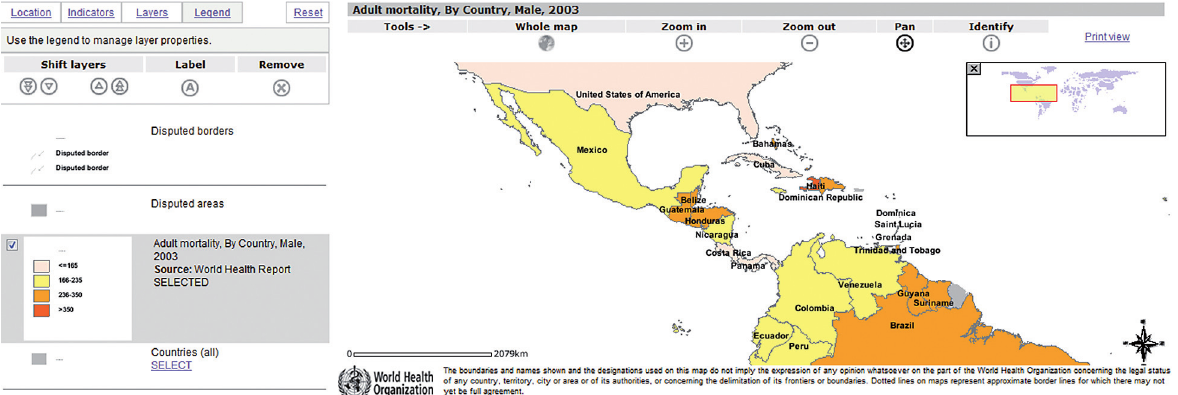
Fig. 2. Map of mortality of adult men in Central America in 2003 produced by Interactive mapping tool (WHO GHA